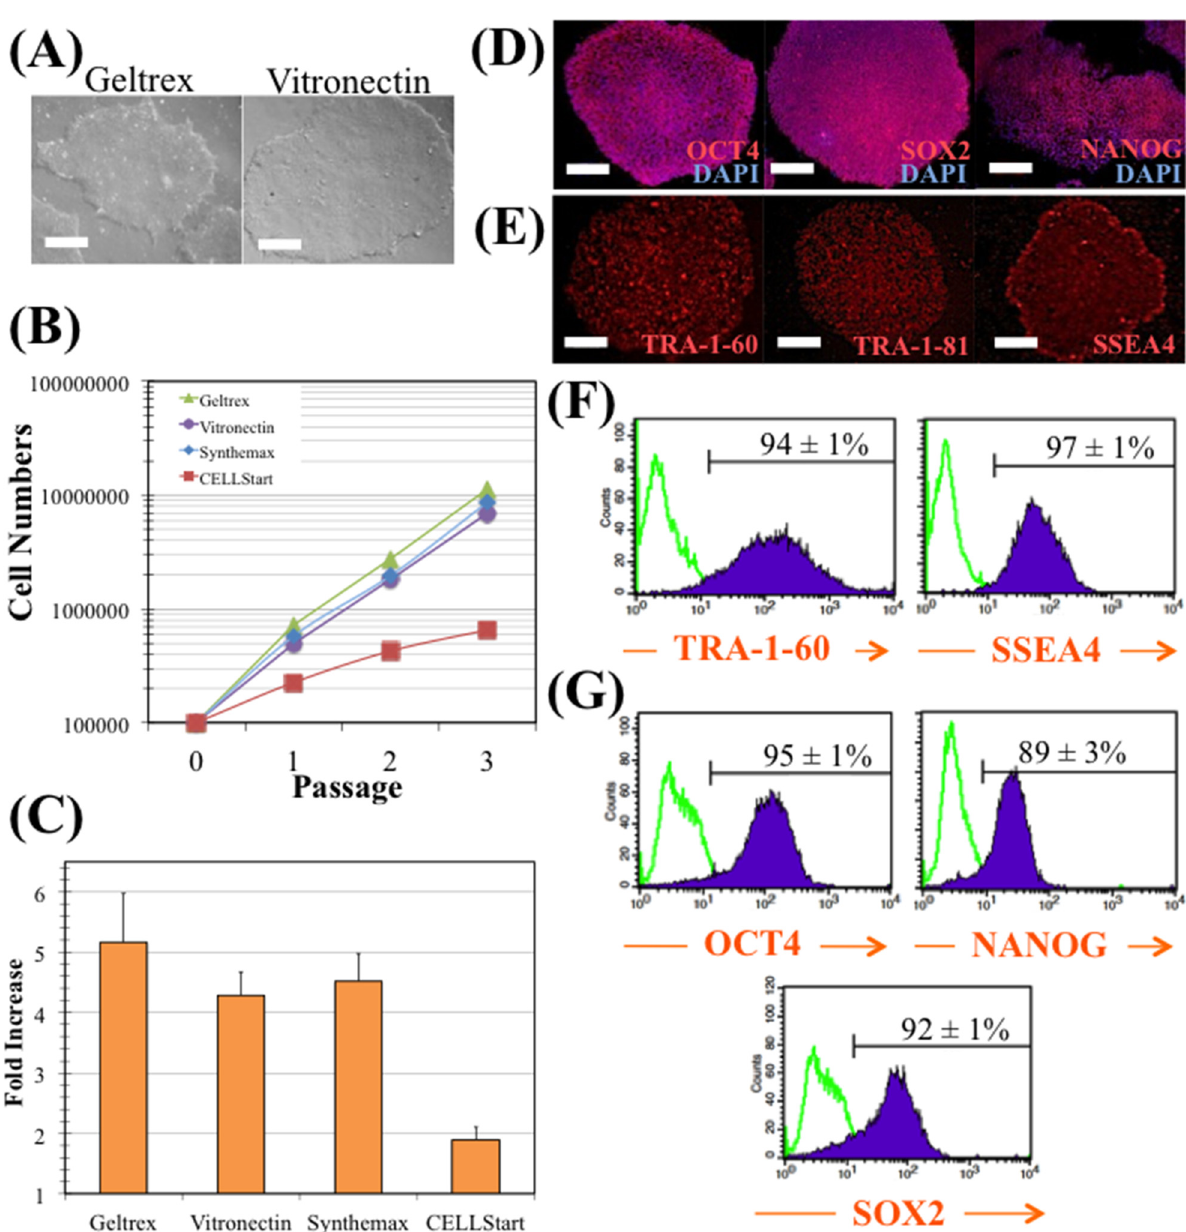
Fig 1. hiPS cell maintenance in E8 medium and vitronectin. (A) Colonies cultured with E8 medium in Geltrex (left panel), and in vitronectin (right panel). Scale bars — 100 μ m. (B) Cumulative fold increase in total cell numbers over four passages with E8 medium in Geltrex (green), in vitronectin (purple), in Synthemax 1 (blue) or in CELLStart ™ (red). (C) Average fold increase per passage. The fold increase was 5.2 for cells growing in Geltrex, 4.3 for vitronectin, 4.5 for Synthemax 1 and 1.9 for CELLStart ™ . Error bars represent SEM (standard error of the mean). Four passages and two independent experiments were performed. (D) Immunostaining of colonies cultured with E8 medium in vitronectin. Colonies were stained for pluripotency markers OCT4, SOX2, and NANOG, and nuclei counterstained with DAPI. Scale bars — 100 μ m. (E) Immunostaining of colonies cultured with E8 medium in vitronectin. Colonies were stained for pluripotency surface markers TRA-1-60, TRA-1-81, and SSEA4. Scale bars — 100 μ m. (F) and (G) Flow cytometry analysis of pluripotency surface markers (TRA-1-60 and SSEA4) (F) and transcription factors (OCT4, NANOG, SOX2) (G) in cells expanded with E8 medium and vitronectin. treatment and inoculated as cell clumps; and in strategy (c) cells were dissociated with EDTA treatment and were inoculated as cell clumps, in the presence of ROCK inhibitor for 24 h.